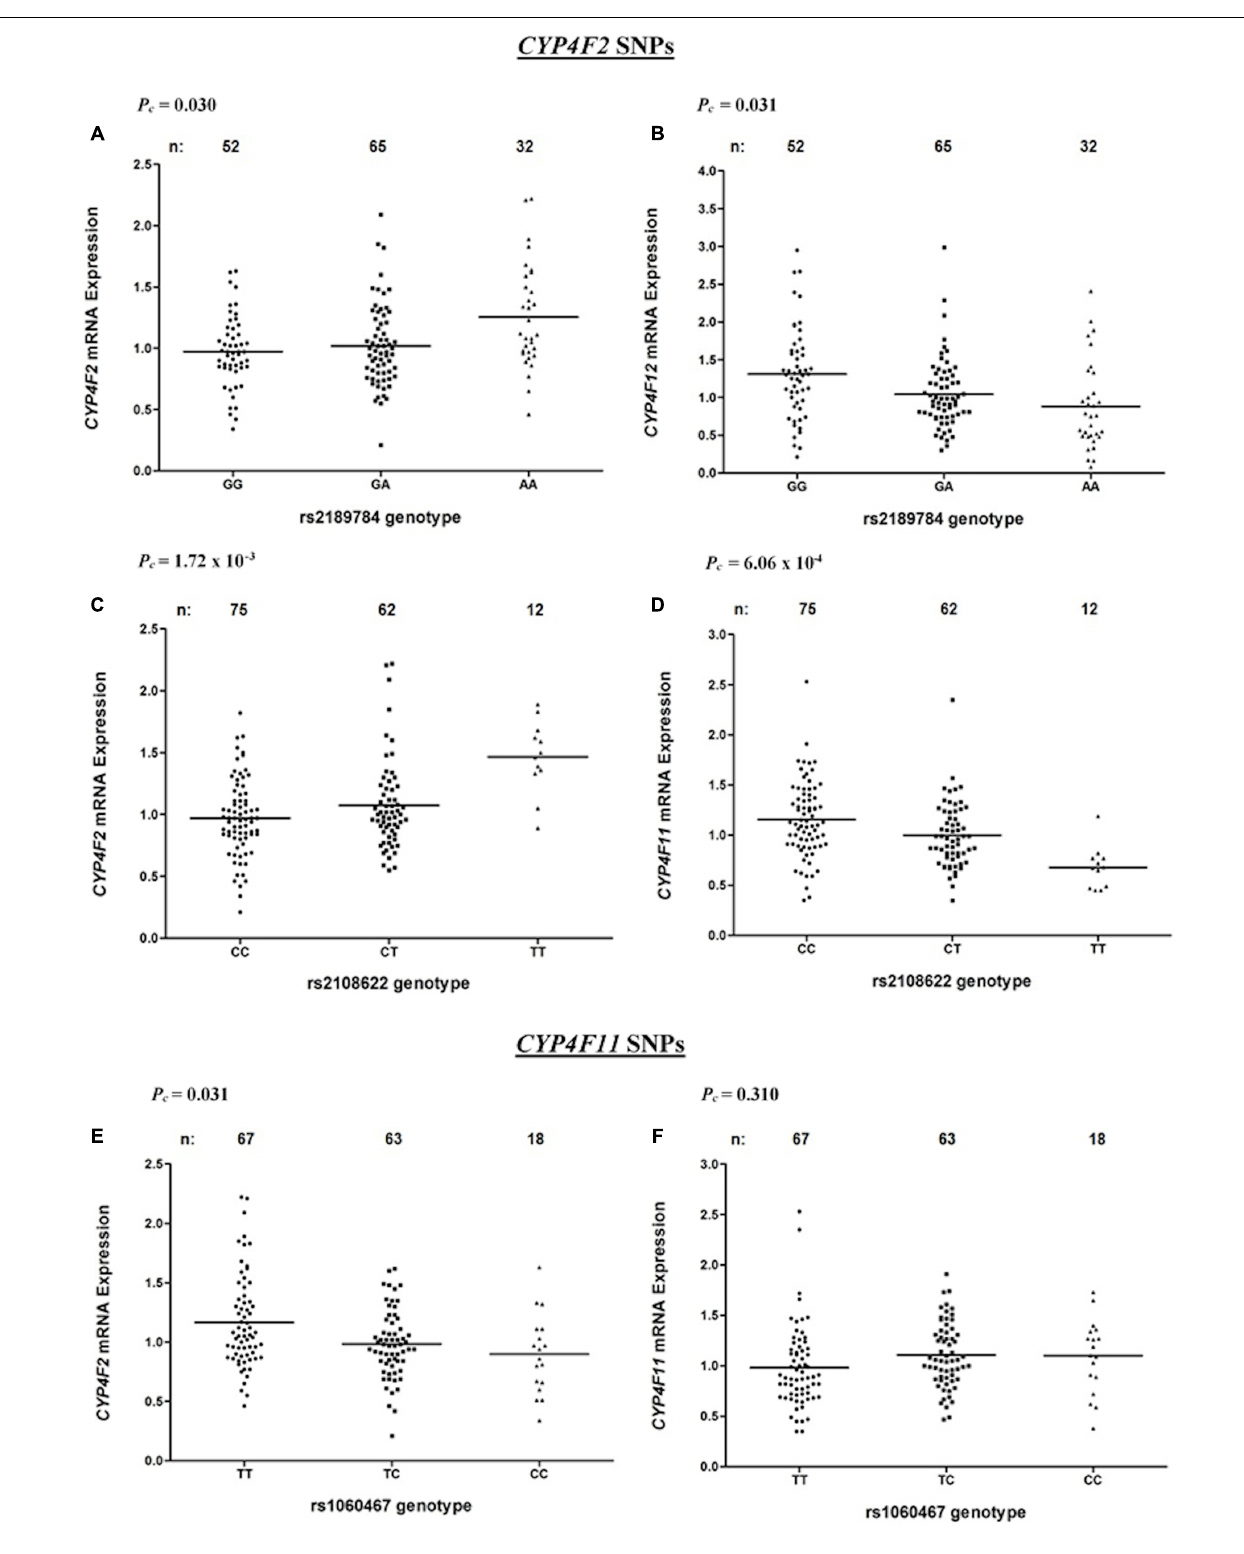
FIGURE 2 | Levels of CYP4F2 , CYP4F11 , CYP4F12 mRNA in normal liver tissue donated from 149 patients in relation to corresponding SNPs across the CYP4F2 - CYP4F11 locus. (A,B) rs2189784; (C,D) rs2108622; (E,F) rs1060467. FDR -corrected P -values ( P c ) are shown in the upper left corner. Each dot represents an individual and the solid lines represent the mean